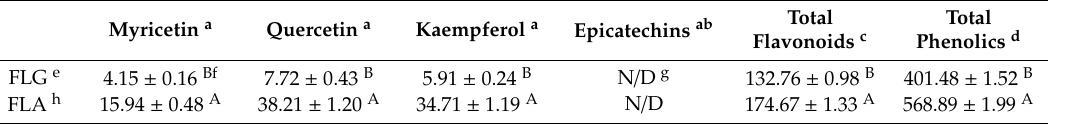
Table 2. Phenolic concentrations of the fractions rich in flavonol glycosides (FLG) and flavonol aglycones (FLA).